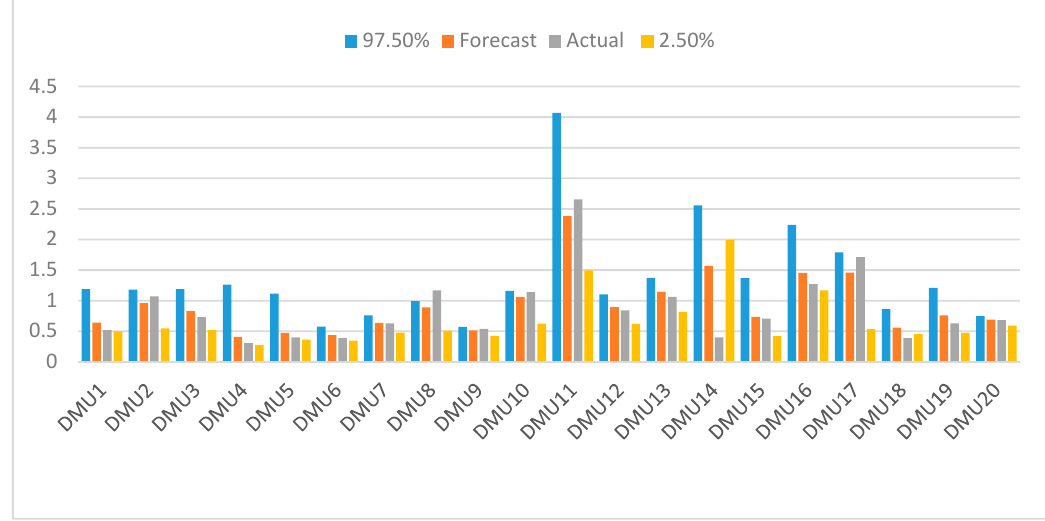
Figure 2. The confidence interval, forecast score, and actual 2019 score forecast by Lucas model.